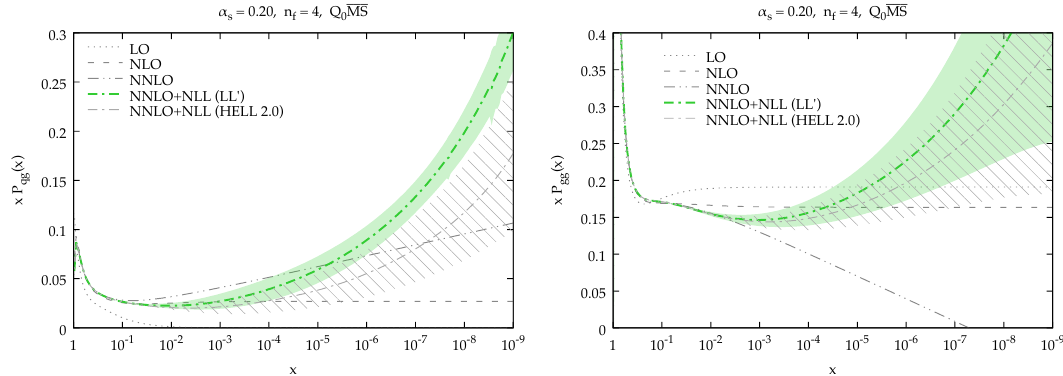
Figure 5 . Comparison between resummed and matched splitting functions in HELL 3.0 with LL 0 anomalous dimension and HELL 2.0 , which contained a